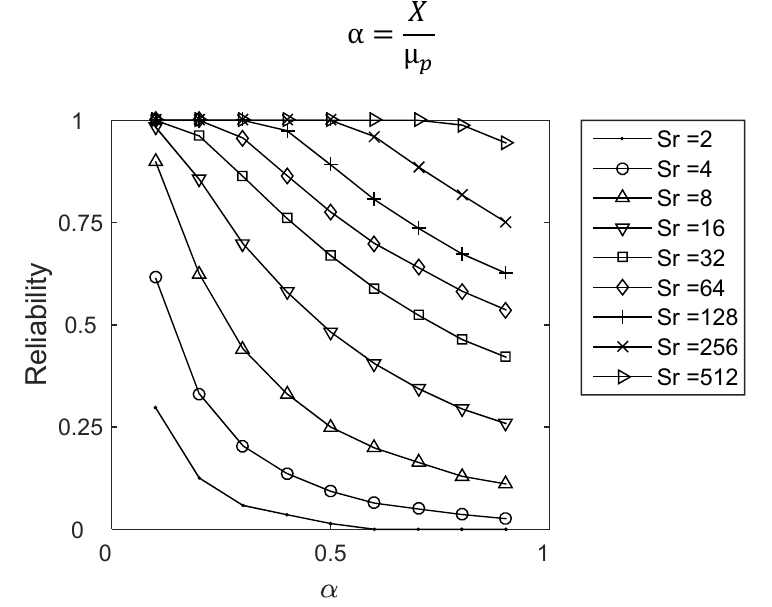
Figure 3. Storage-reliability-yield relation curves based on historical rainfall data (1970–1999) in a test catchment, 1018, depending on yield ratio ( α ) and storage size ( Sr ) in mm/m 2